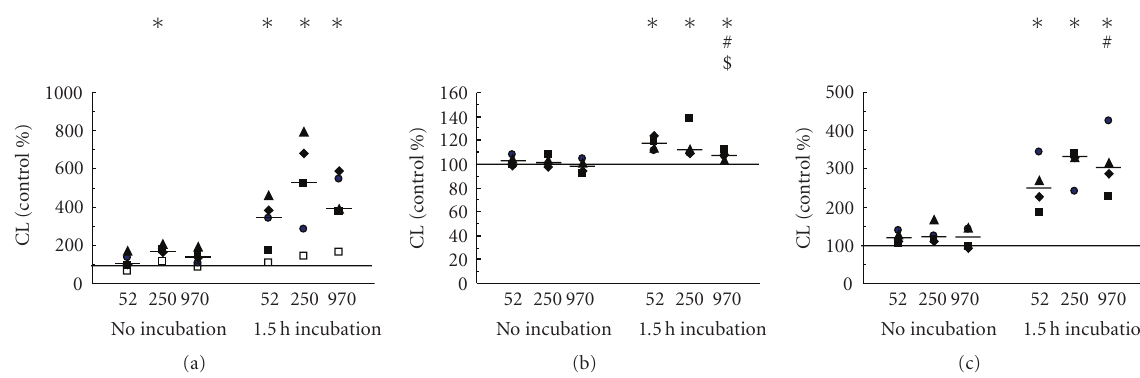
Figure 3: E ff ect of di ff erent MW HA (10 μ g/mL) on spontaneous (a), OZP-activated (b), and-starch activated (c) ROS production measured in diluted whole blood by luminol-enhanced chemiluminescence, immediately or after 1.5h pre-incubation after addition of HA. The bold line represents the median, and data points from parallel measurements are presented by the same symbol. Statistically significant di ff erences among di ff erent groups ( P < . 05) are marked by di ff erent symbols: ( ∗ ) statistical significance to control, (#) statistical significance to sample incubated with 52 kDa HA, and ($) statistical significance between samples incubated with 250kDa and 970kDa